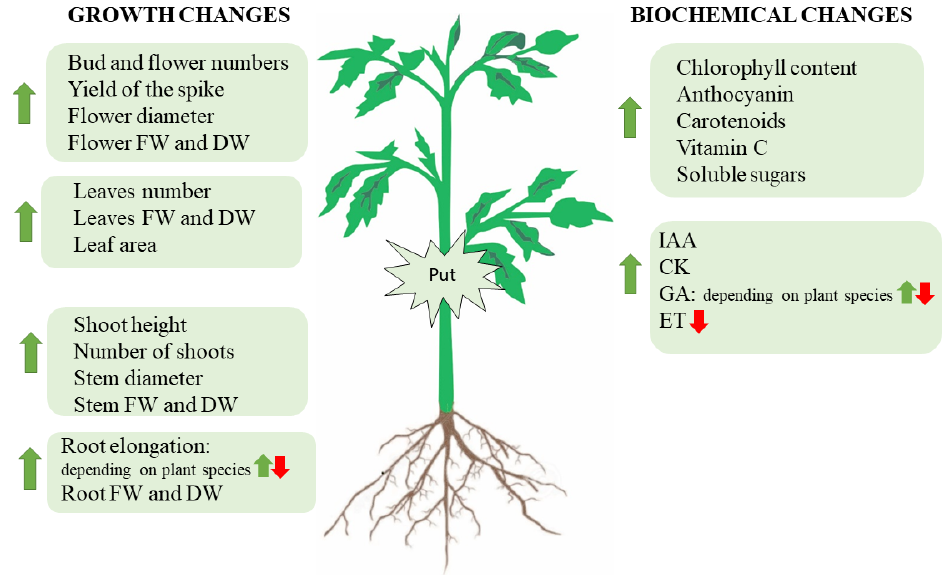
Figure 2. Developmental and biochemical changes produced in plants under Put treatment. FW: fresh weight; DW: dry weight; IAA: indole acetic acid; GA: gibberellins; CK: cytokinins; ET: ethylene